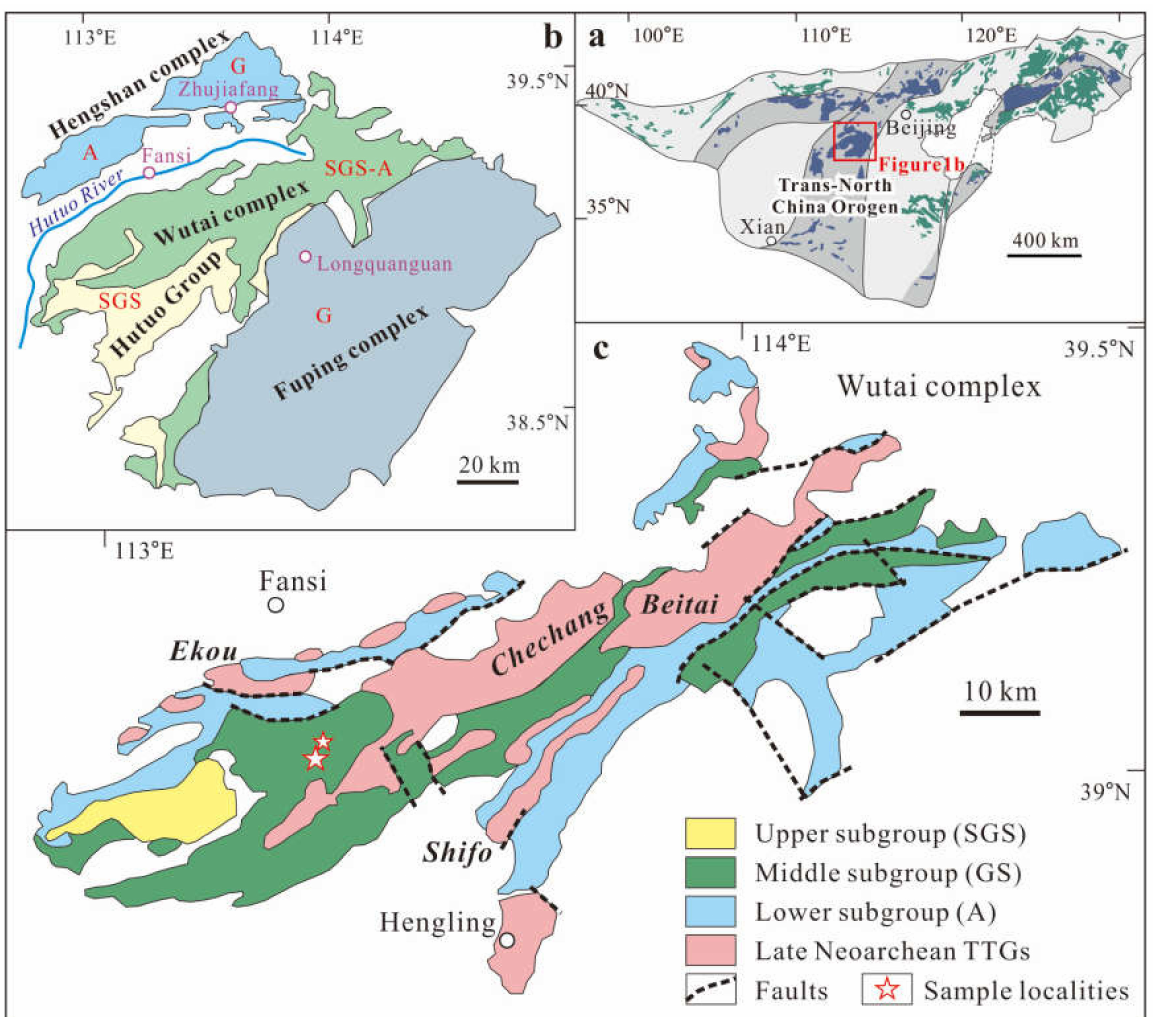
Figure 1. ( a ) Tectonic sketch of the North China Craton. ( b ) Geological map showing the distribution and metamorphic grades of the Wutai, Hengshan, and Fuping complexes and the Hutuo Group. G : granulite facies; A : amphibolite facies; GS : greenschist facies; SGS : sub-greenschist facies; ( c ) Geological map showing the lithological units in the Wutai Complex, including the three subgroups of Wutai Group and TTG gneisses. The localities of BIF and chlorite schist (Kangjiagou, large star) and pillow basalt (Taping, small star) are also shown. The tectonic division of the North China Craton is in accordance with [21]. Metamorphic grades of each geological unit and classification of subunits in the Wutai Complex are in accordance with